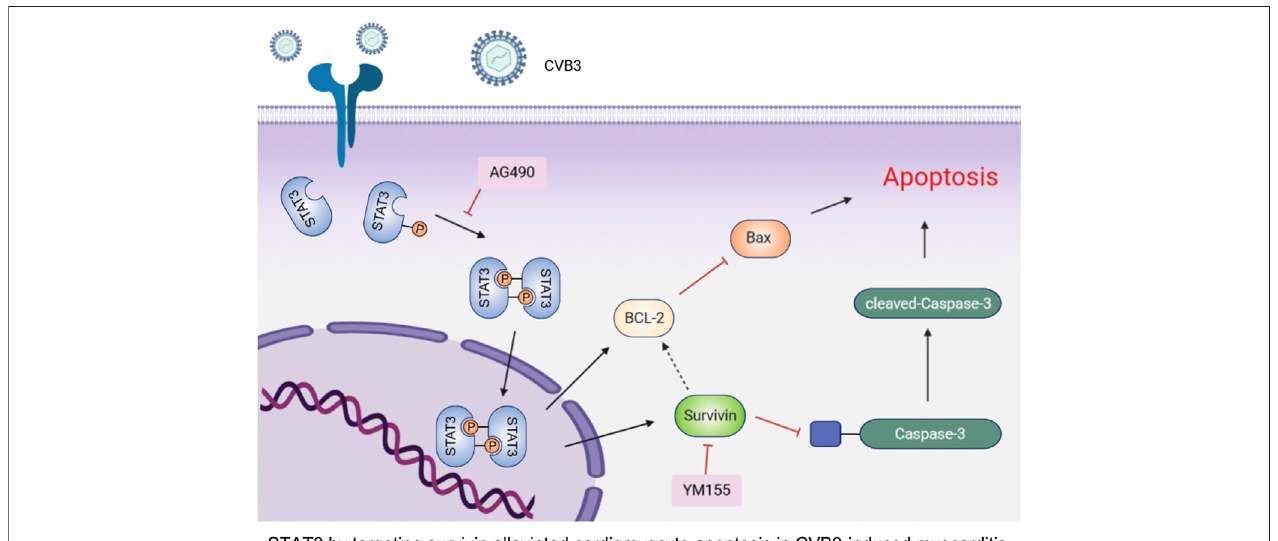
FIGURE 6 | STAT3 by targeting survivin alleviated cardiomyocyte apoptosis in CVB3-induced myocarditis.